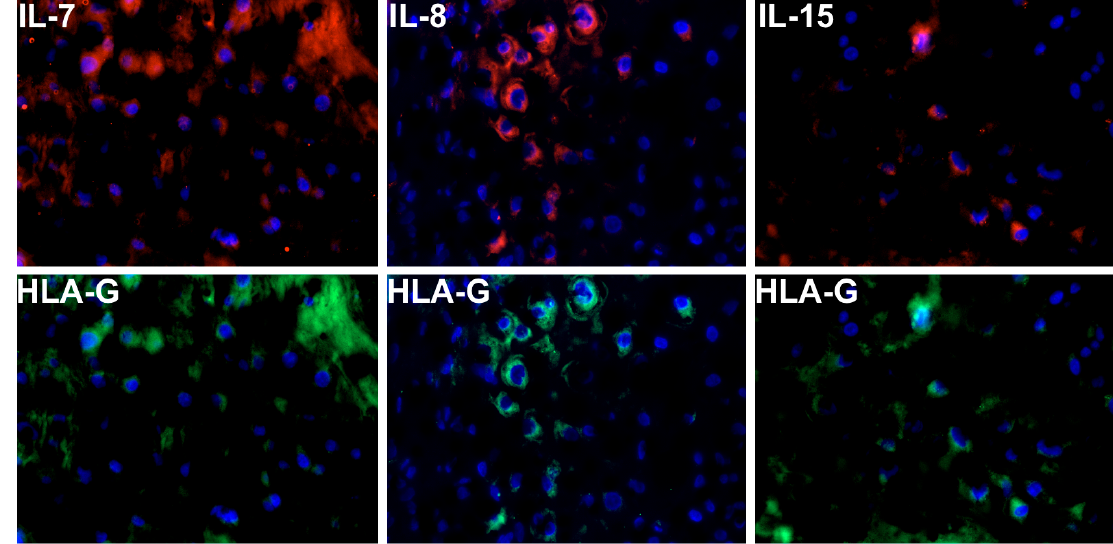
Figure 5. Double immunofluorescence staining was used for the simultaneous proof of the respective interleukin and HLA expression in cells of EVT. Cy3 marked antibodies (red staining) are showing the respective interleukin expression (first line of the figure). HLA-G antibodies (FITC marked) were used to picture the EVT in green (second line of the figure). Cell nuclei are stained with DAPI in blue.